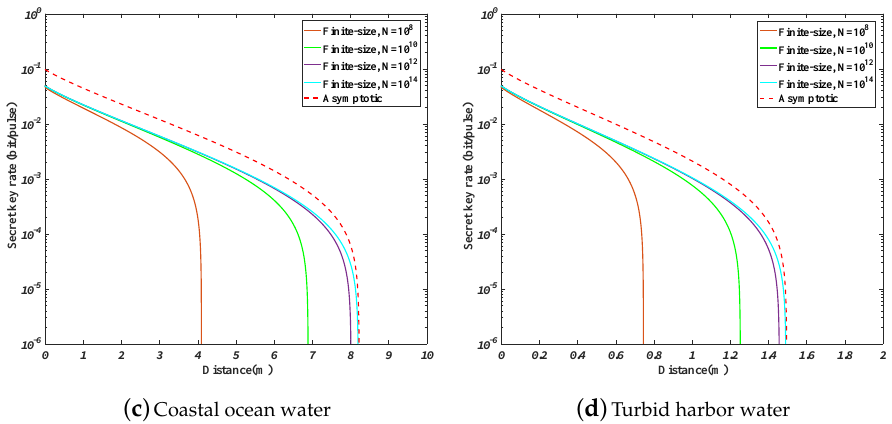
Figure 11. (Color online.) The finite-size and the asymptotic secret key rate of the four-state underwater CV-QKD protocol. From left to right in every sub-figure, curves of different colors correspond, respectively, to block lengths of 10 8 , 10 10 , 10 12 , and 10 14 , and the asymptotic curves.